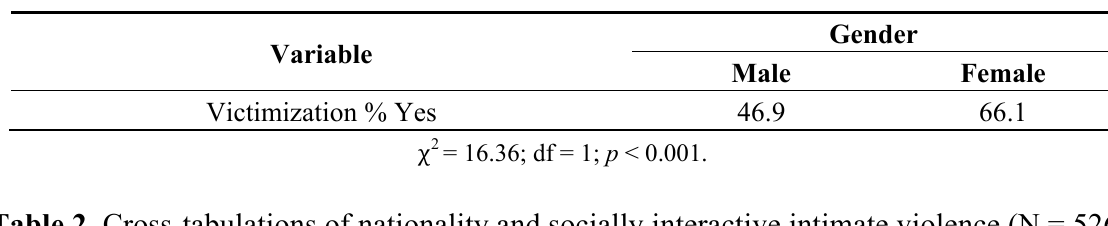
Table 1. Cross-tabulations of gender and socially interactive intimate violence (N = 526).